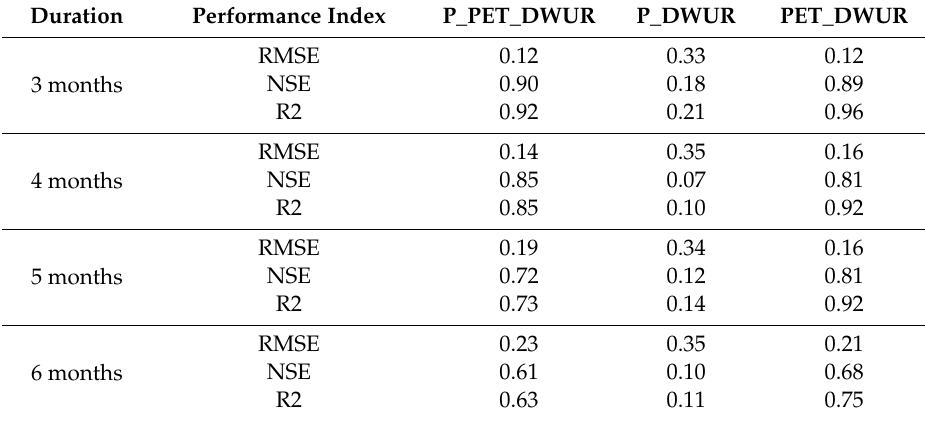
Table 3. Results of the prediction model in the validation